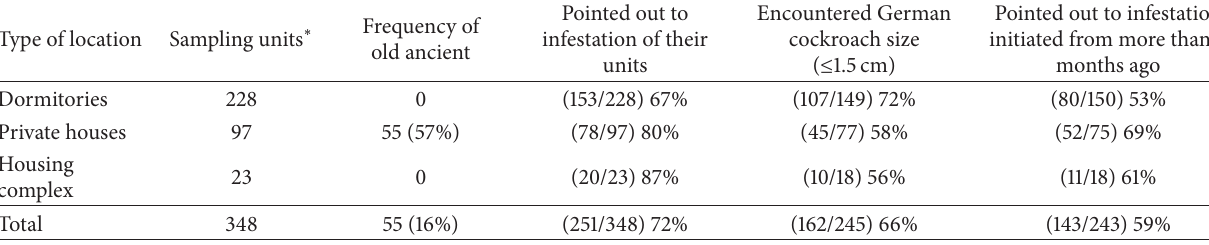
Table 4: Frequency of resident’s responses to four items of questionnaire.